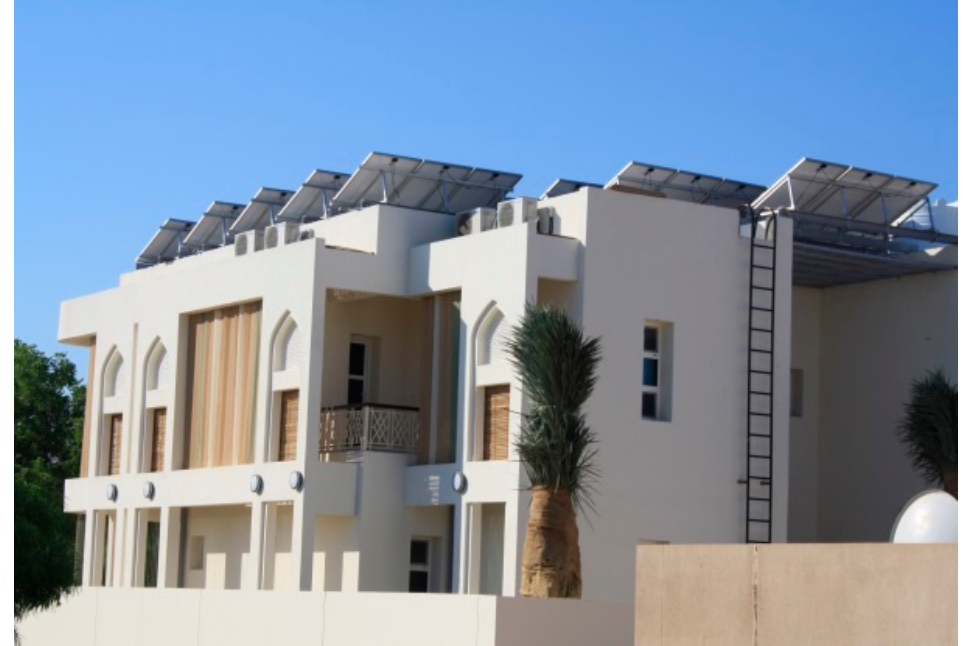
Figure 14. SQU Eco-House equipped with a 20kW PV Array which can supply both to Grid and to the household electrical commodities. The RES here works as distributed energy resource (DER) for the SG.